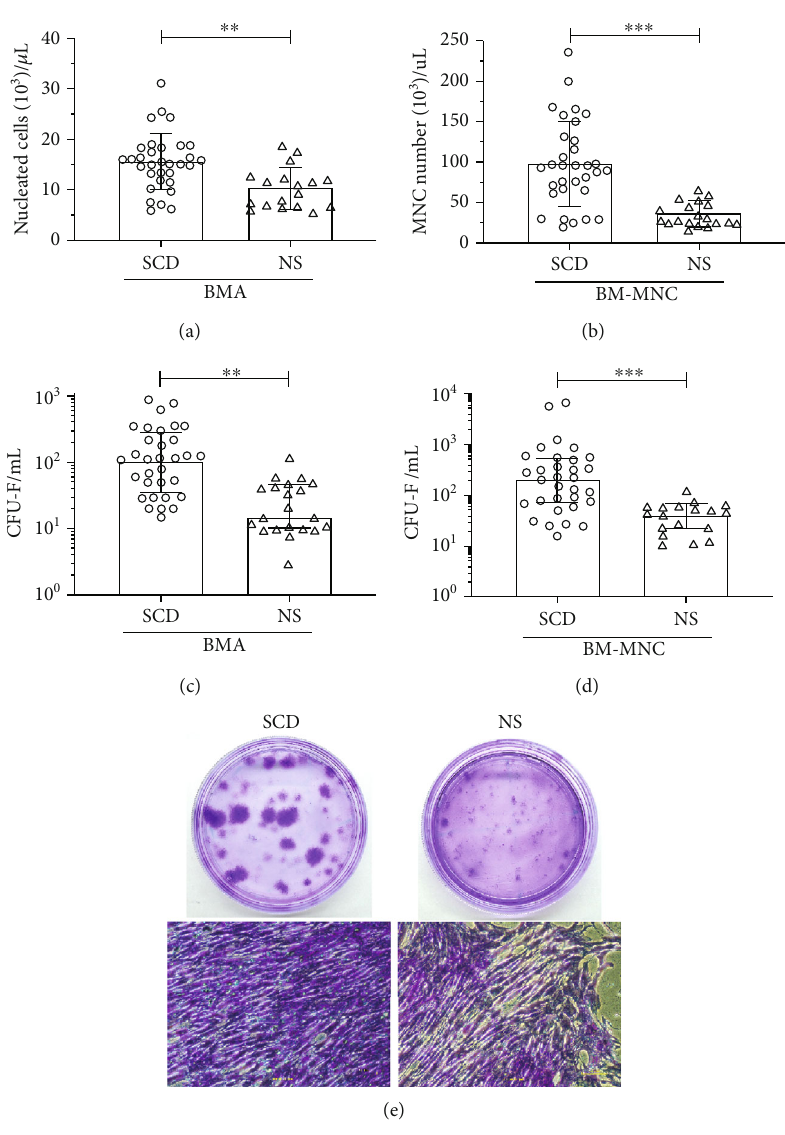
Figure 1: Frequency of CFU-F and BM-nucleated cells. Quanti fi cation of (a, b) nucleated cells and (c, d) CFU-F counts in bone marrow aspirate (BMA) or mononuclear fraction (BM-MNC). (e) Typical CFU-F plates from representative donors showing colonies from di ff erent sizes after crystal violet staining. Statistical analyses (Mann – Whitney U test) were performed between values, and the data are Table 1: Distribution of cell number, progenitor cell populations, and frequency of CFU-F with BM processing. BMA BM-MNC SCD NS p SCD NS